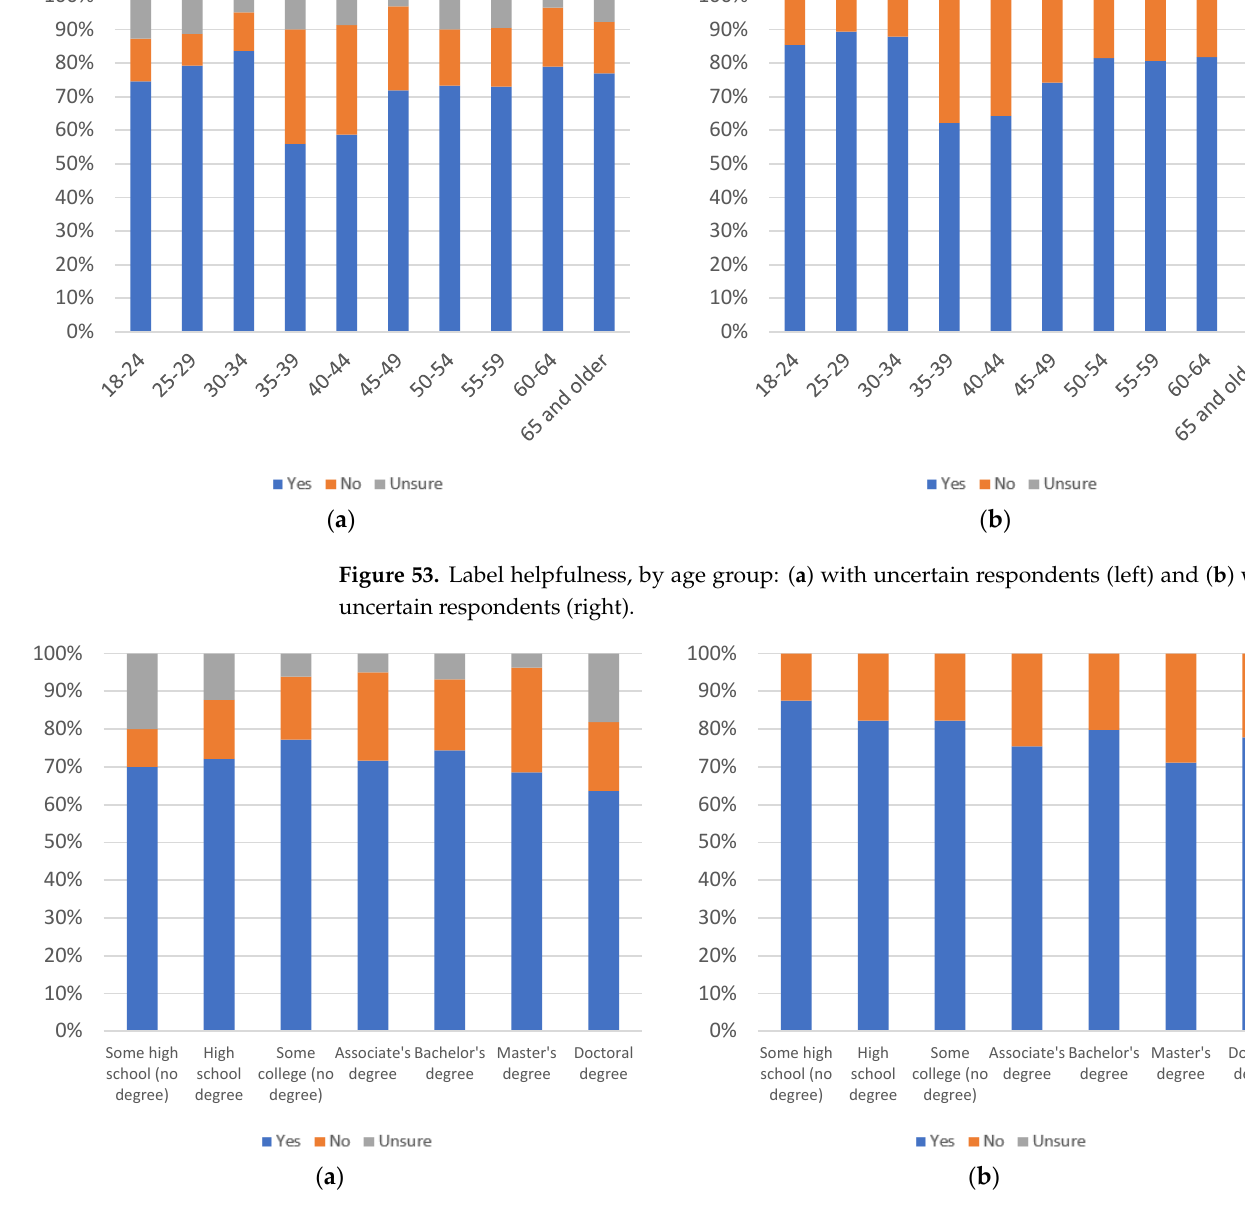
Figure 54. Label helpfulness, by education level: ( a ) with uncertain respondents (left) and ( b ) without uncertain respondents (right).